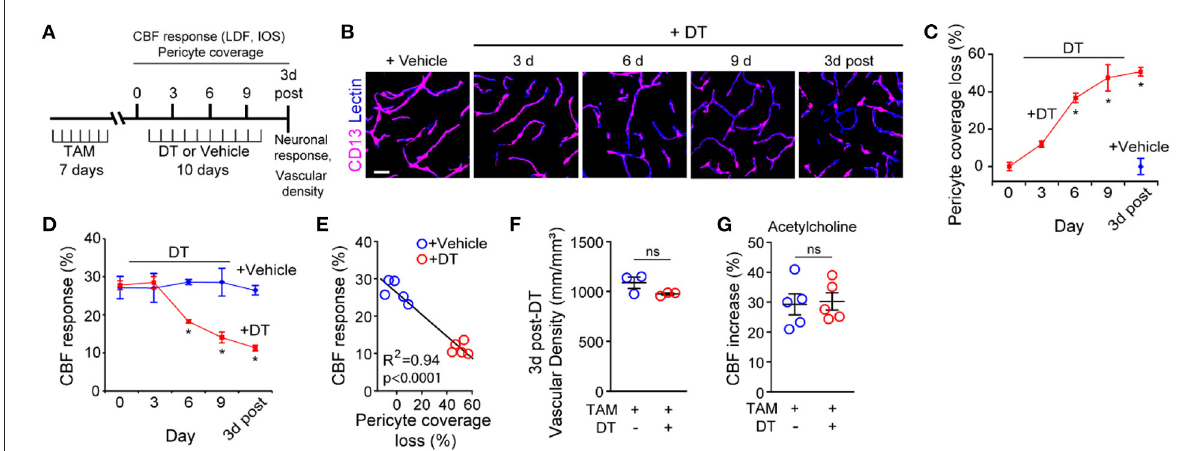
FIGURE1 Ablation of cortical pericytes from the adult mouse brain leads to acute dysregulation of neurovascular coupling. (A) A diagram of the injection protocol of pericyte-CreER; iDTR mice with tamoxifen (TAM; 40 mg/kg daily for seven consecutive days), diphtheria toxin (DT; 0.1mg per day for 10 consecutive days) or vehicle, and the time points when cerebral blood flow (CBF) responses to stimulus measured by laser Doppler flowmetry (LDF) and intrinsic optical signal (IOS) imaging, neuronal response to stimulus, and capillary density measurements were performed. (B) Representative confocal microscopy images of CD13-positive pericyte coverage of lectin-positive endothelial profiles in the S1 cortex hind-limb region at 3, 6, and 9 days of DT or vehicle administration, and 3 days post-DT or vehicle. Bar = 20 µ m. (C) Quantification of pericyte coverage loss on capillaries ( < 6 µ m in diameter) in the S1 cortex in TAM-treated pericyte-CreER; iDTR mice at 0, 3, 6, and 9 days of DT administration, and 3 days post-DT or vehicle treatment; n = 5 mice per group. * P < 0.05 vs. day 0 of DT treatment by analysis of variance (ANOVA) followed by Tukey’s post hoc test. (D) CBF response to an electrical hind limb stimulus (60s duration, 7Hz, 2ms pulse duration) in 3-month-old TAM-treated pericyte-CreER; iDTR mice determined by LDF in the S1 cortex hind-limb region at 0, 3, 6, and 9 days of DT or vehicle administration, and 3 days post-DT or vehicle treatment. CBF response is expressed as the percentage increase relative to baseline; n = 5 mice per group; * P < 0.05, by ANOVA followed by Tukey’s post hoc test. (E) Pearson’s correlation between CBF response to a stimulus as in (D) and loss of pericyte coverage determined at 3 days post-DT or vehicle treatment of TAM-treated pericyte-CreER; iDTR mice. Each point represents an individual response per mouse of 10 studied mice; P < 0.0001. Significance by two-tailed Pearson correlation; R, Pearson correlation coefficient. (F) Capillary (diameter < 6 µ m) density in the S1 cortex hind-limb region in TAM-treated pericyte-CreER; iDTR mice at 3 days post-DT or vehicle treatment; n = 3 mice per group. (G) LDF measurements of CBF response to endothelium-dependent vasodilator acetylcholine (10 µ M) in TAM-treated pericyte-CreER; iDTR mice determined 3 days post-DT or vehicle treatment; n = 5 mice per group. Data in (C,D,F,G) represented as Mean ± SEM; in (F,G) ns, non-significant by Student’s t -test. Circles denote individual values per mouse in (E–G)